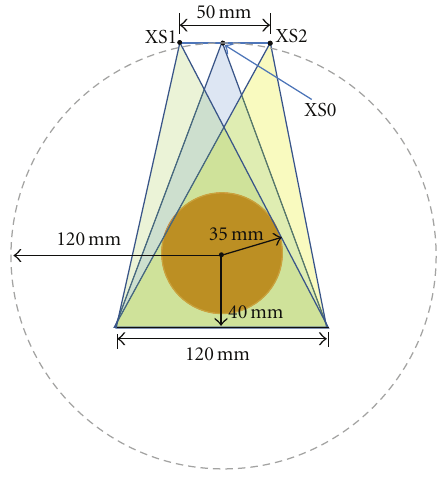
Figure 2: Geometrical configuration of a triple-source micro-CT